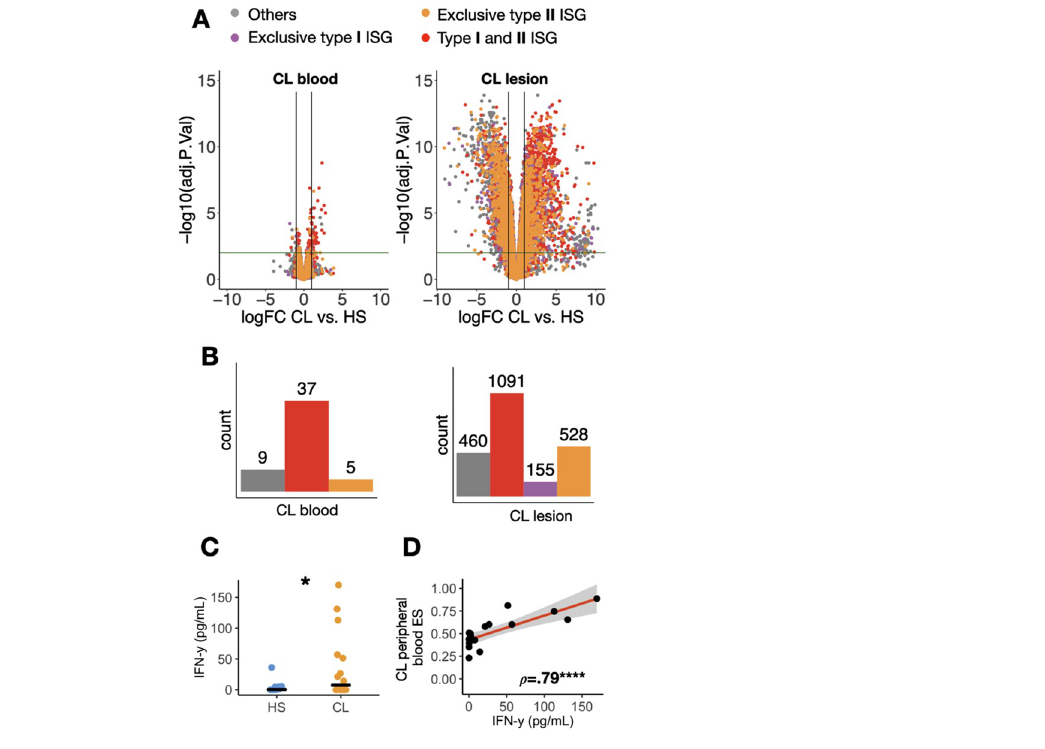
Fig 2. An Interferon-stimulated type II gene (ISG) systemic signature parallel the local immune response in the CL lesion. (A) Volcano plots with differentially expressed genes in the peripheral blood (left) and lesion (right) in CL patients relative to HS. Genes were colored according to their ISG classification: gray, not an ISG; purple, an ISG exclusively induced by type I Interferons; red, an ISG exclusively induced by type II Interferon; and yellow, an ISG induced by both type I and II Interferons. Horizontal and vertical lines indicate FDR = 0.01 and logFC = 1, respectively). (B) Histograms show the number of overrepresented type I and type II ISGs from volcano plots above in A. (C) IFN- γ levels in the serum of 17 CL patients infected with L . braziliensis and ten healthy subjects (HS). Wilcoxon rank-sum test was used for statistical analysis. � P < 0.05. (D) A Spearman correlation between the 51-gene peripheral blood leishmanial signature enrichment score (ES) and the levels of IFN- γ in the serum of CL patients. ρ , Spearman’s rho correlation coefficient; ���� P > 0.0001.